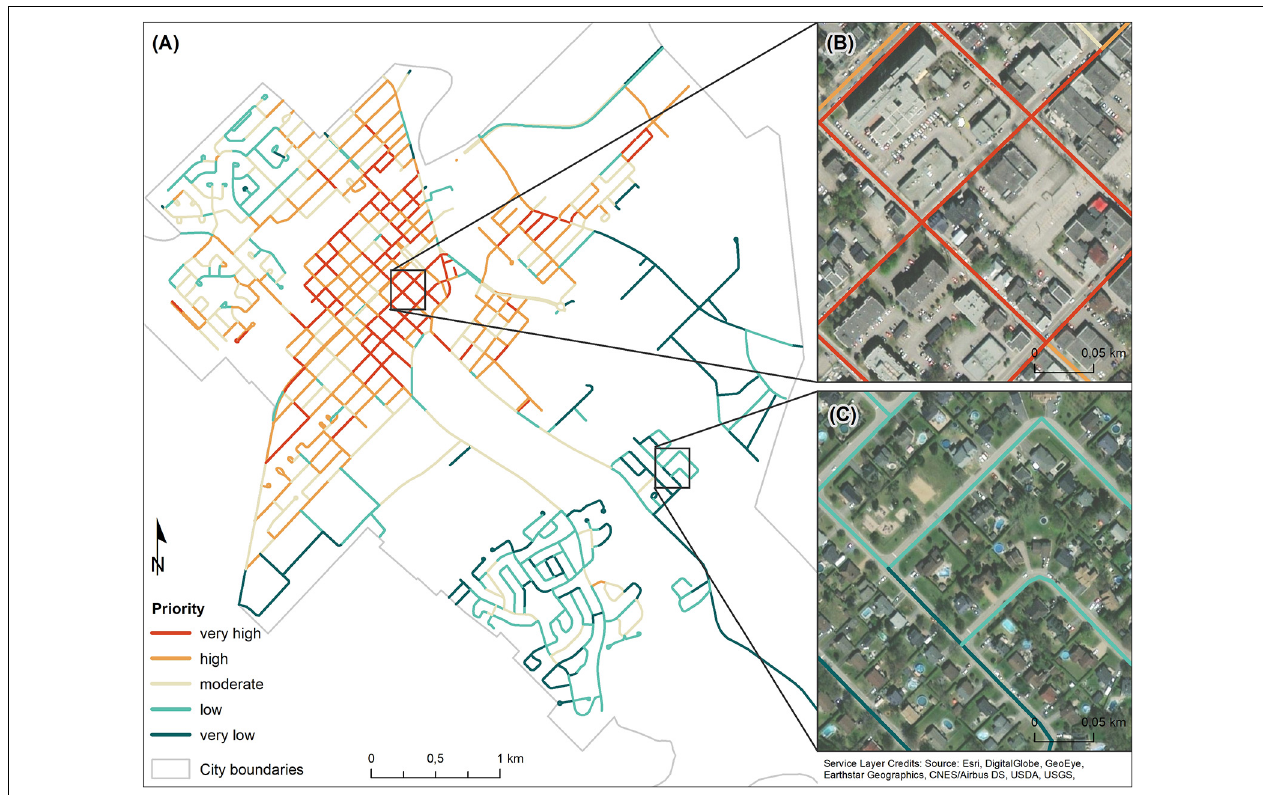
FIGURE 3 | Tree planting priority map for the City of Joliette with heat reduction as the overarching goal (heat reduction scenario). Map of the city’s street segments network (A) , with insets showing high (B) and low priority areas (C) for tree planting on a larger scale. Street segments shown in red have a higher priority for